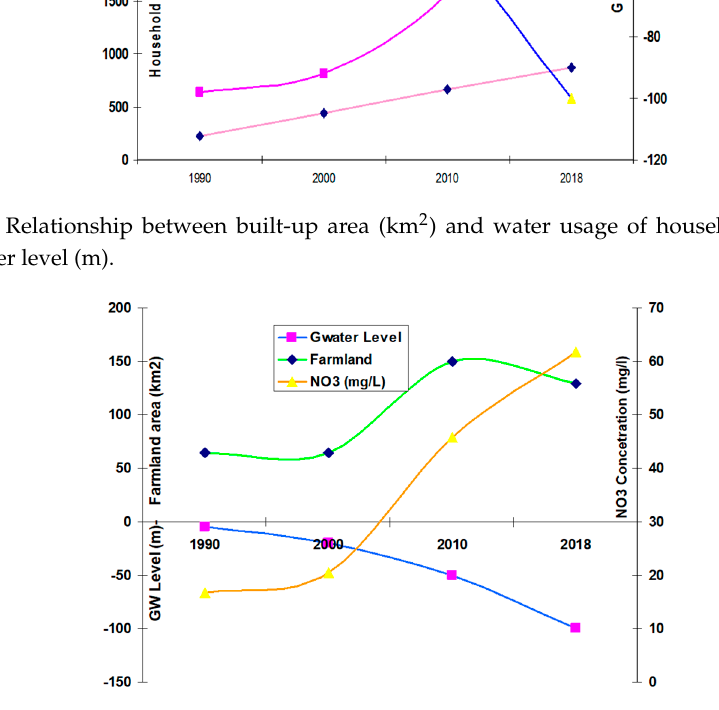
Figure 15. Spatiotemporal variations of water usage (mcm), and groundwater level vs the coverage of the irrigated agricultural area.